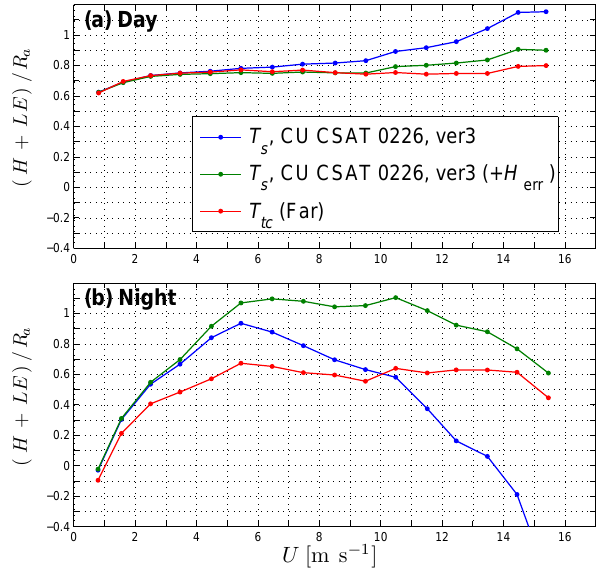
Fig. 11. The surface energy balance closure fraction [CF=( H +LE)/ R a ] versus horizontal wind speed U for years 2006–2007 for (a) daytime and (b) nighttime conditions ( R a = R net − G is the available energy; see text for details). R net is measured with a REBS, model Q*7.1 radiometer. The temperature sensor used to calculate H is specified in the legend. The calculation of H err for CSAT 0226 uses the coefficients shown in Fig. 10c. This figure is comparable to Fig. 7 in Turnipseed et al.